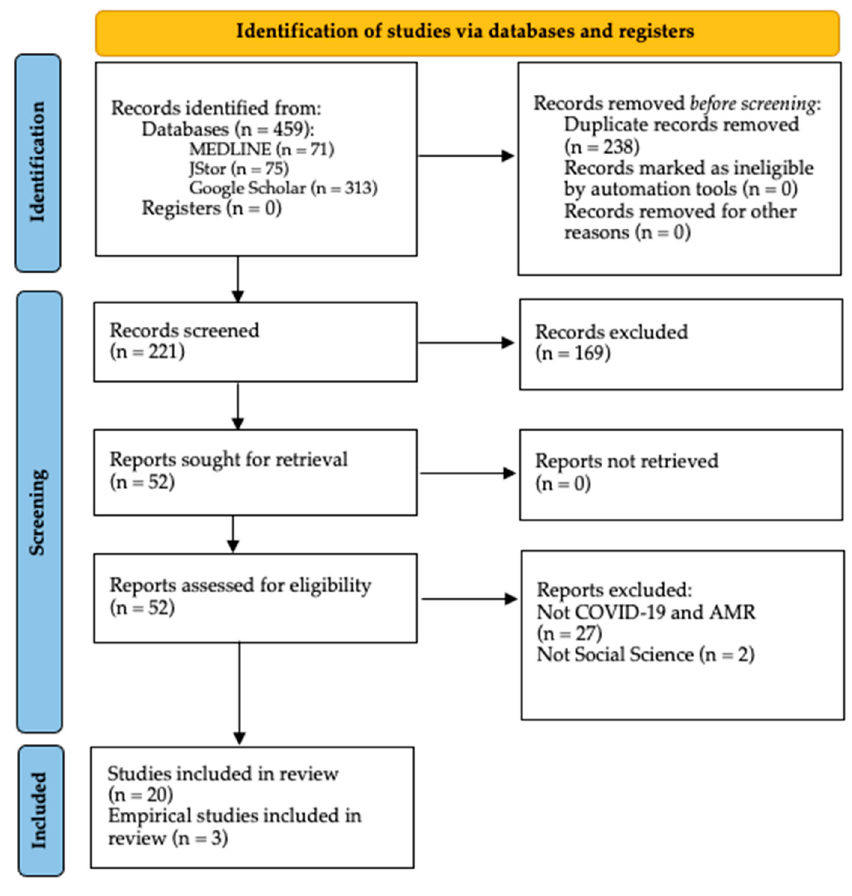
Figure 2. PRISMA flow diagram.